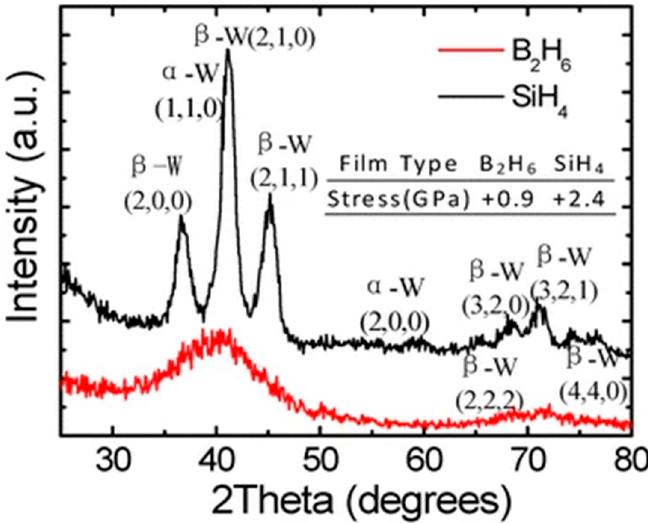
Figure 28. XRD patterns of ALD W grown by SiH 4 and B 2 H 6 precursors and the estimated stress [166].